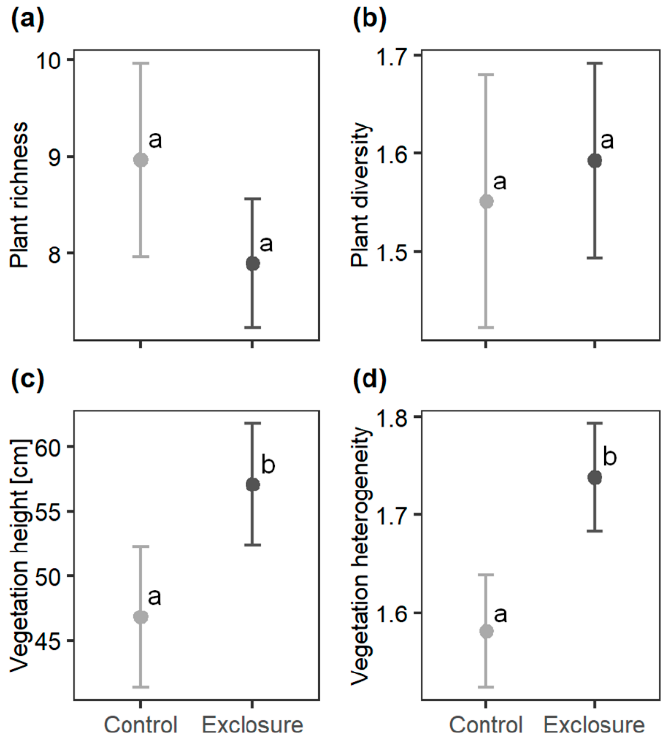
Figure 1. Depicts means (± SE) of ( a ) plant species richness, ( b ) plant diversity, ( c ) vegetation height and ( d ) vegetation heterogeneity in control (light grey) and exclosure plots (dark grey). Statistical differences ( p < 0.05) are indicated with different lowercase letters.